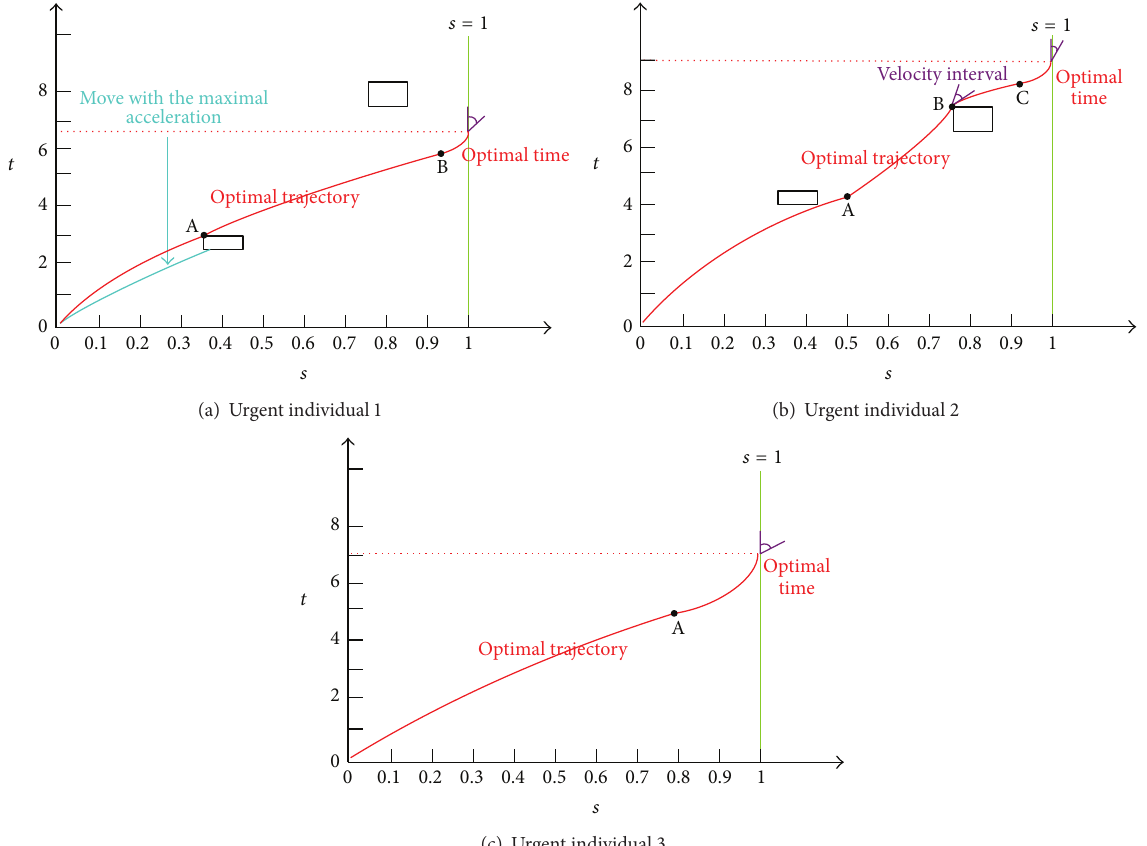
Figure 8: The optimal trajectory, time, and the velocity interval of urgent individuals.